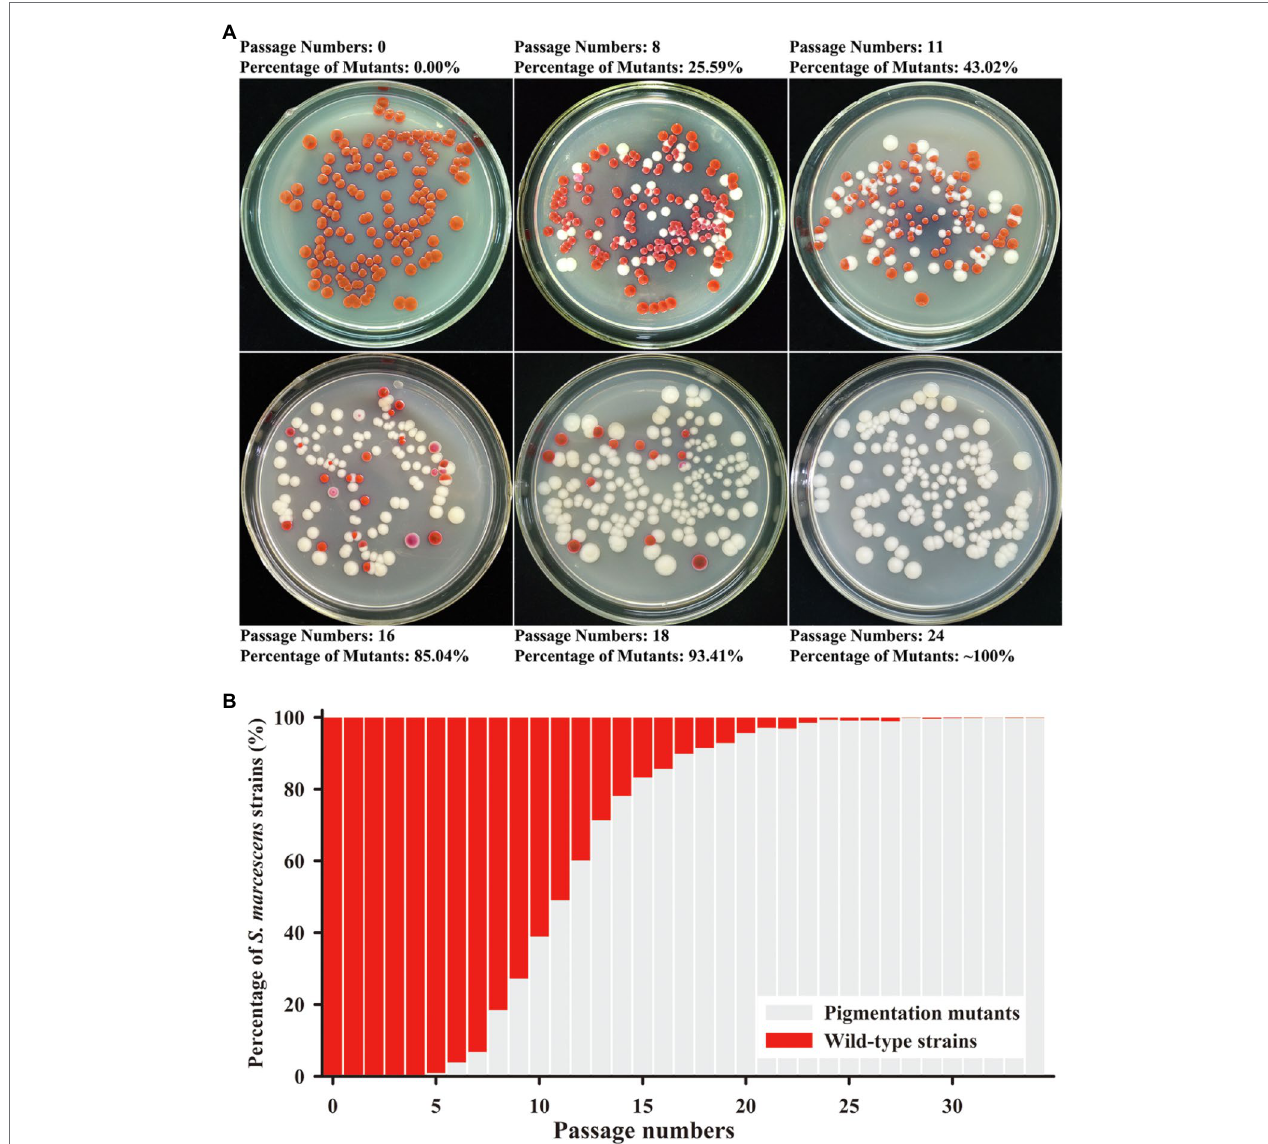
FIGURE 1 | Mutation trend of Serratia marcescens during continuous passages. (A) Colonies on Luria-Bertani (LB) plate at the representative generations of passage. The percentage of color mutants is labeled upside. (B) The percentage of wild-type strains and mutants in each generation of